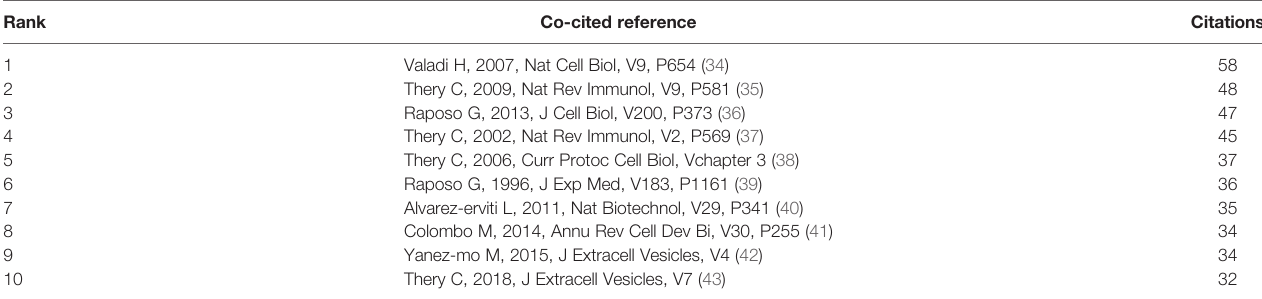
TABLE 4 | Top 10 co-cited references on research of exosomes in AIDs.